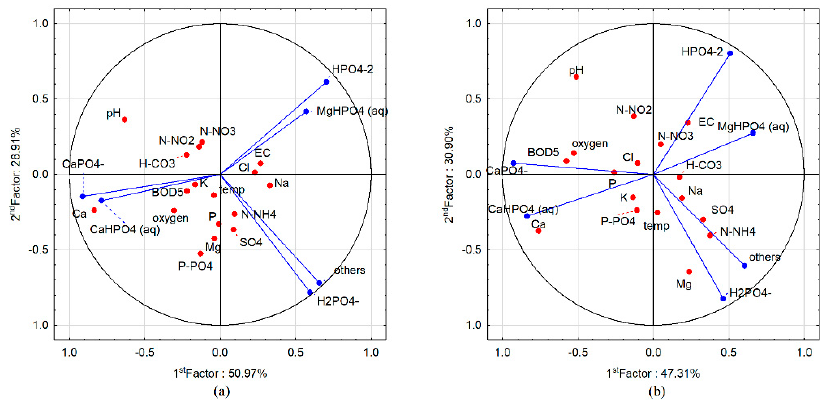
Figure 8. Analysis of the main components of the speciation forms of orthophosphates (V) in the waters of Lake Kórnickie in relation to physicochemical parameters in water of Lake Kórnickie; ( a ) for SP JK1 and ( b ) for SP JK2.